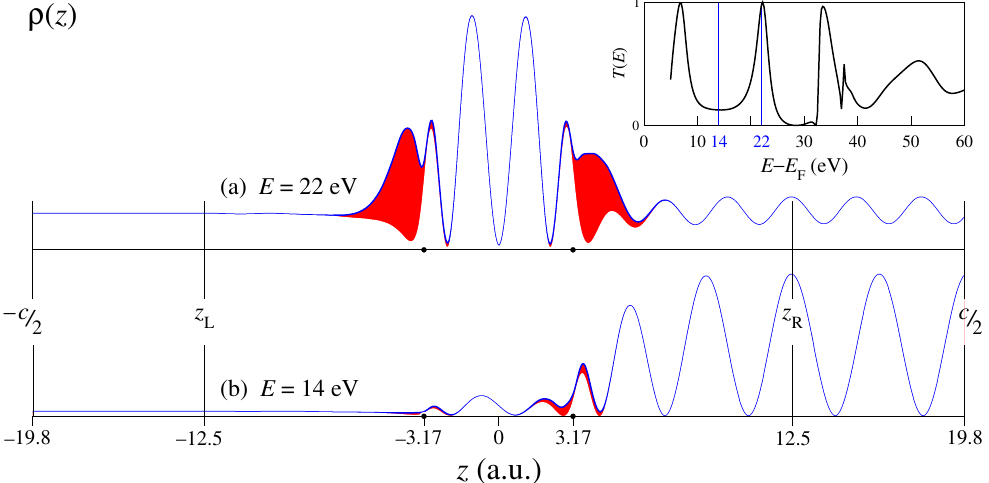
Figure 1. Density profile ρ ( z ) , see Equation (3), of two LEED states at normal incidence at the AB -stacked graphene bilayer: ( a ) E − E F = 22 eV, ( b ) E − E F = 14 eV. The carbon layers are at z = ± 3.17 a.u. The shaded areas show the contribution from the G || (cid:54) = 0 surface Fourier harmonics. The inset shows the normal incidence transmission